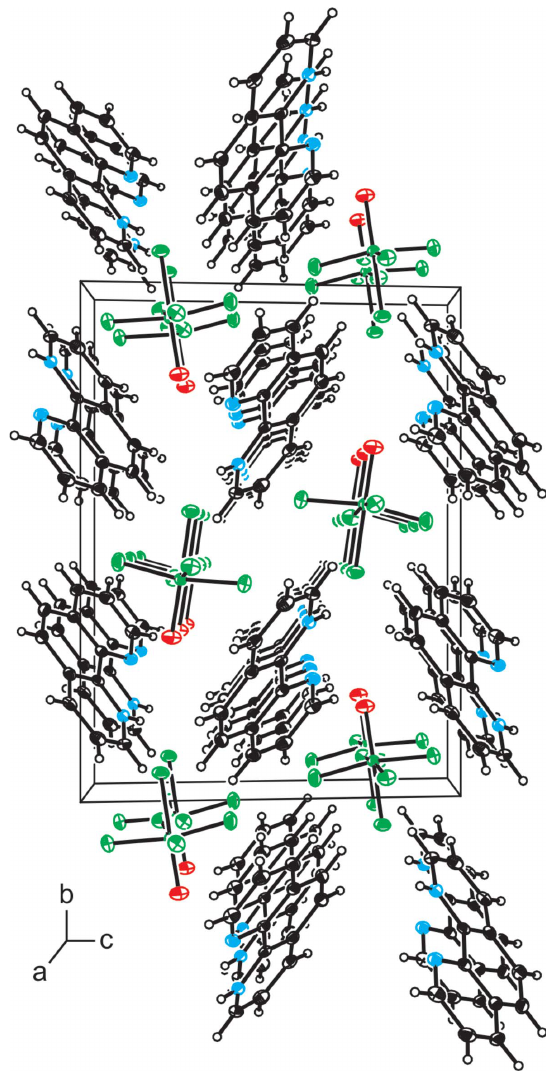
Figure 2 Crystal packing of (1,10-phen-H)[WOF 5 ] viewed along the a axis.